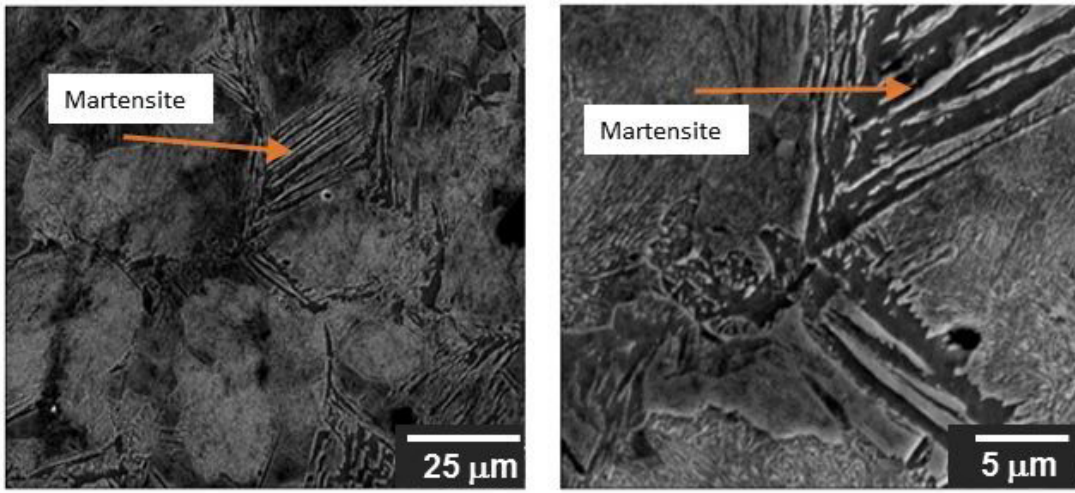
Figure 13. Microstructure of 1035 steel deformed at 785°C, 1000X and 4000X, strain rate 10 -1 s -1 . Martensite in a ferritic matrix.